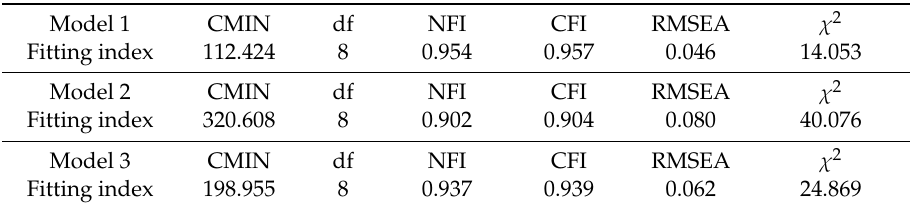
Table 2. Test statistics for hypothesized